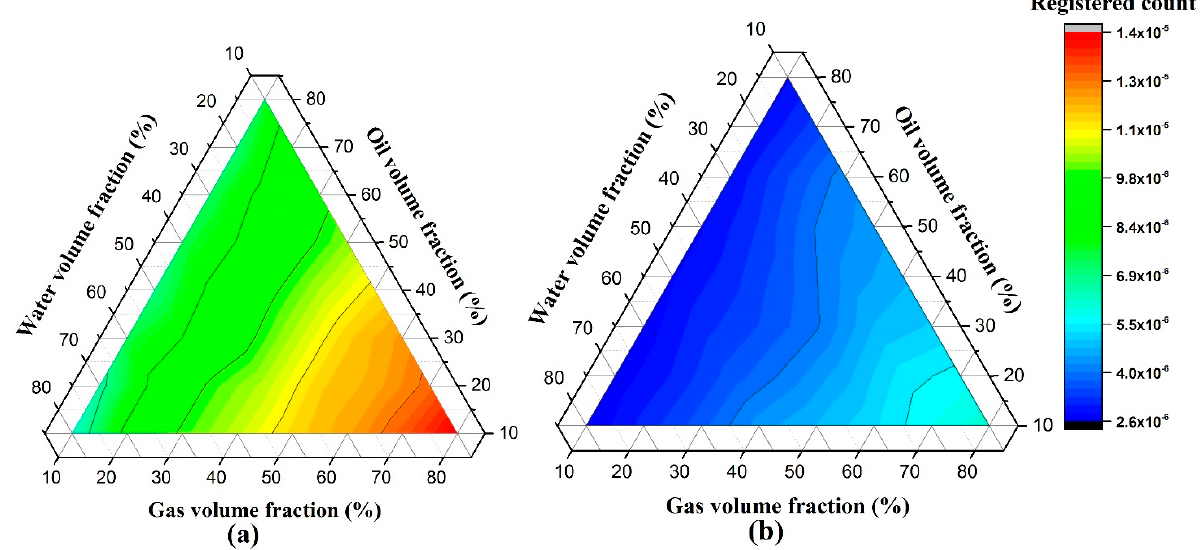
Figure 7. Recorded counts under photo peaks of 241 Am in the first detector versus gas, oil, and water volume fraction: ( a ) scale thickness is 0, ( b ) scale thickness is 3 cm.